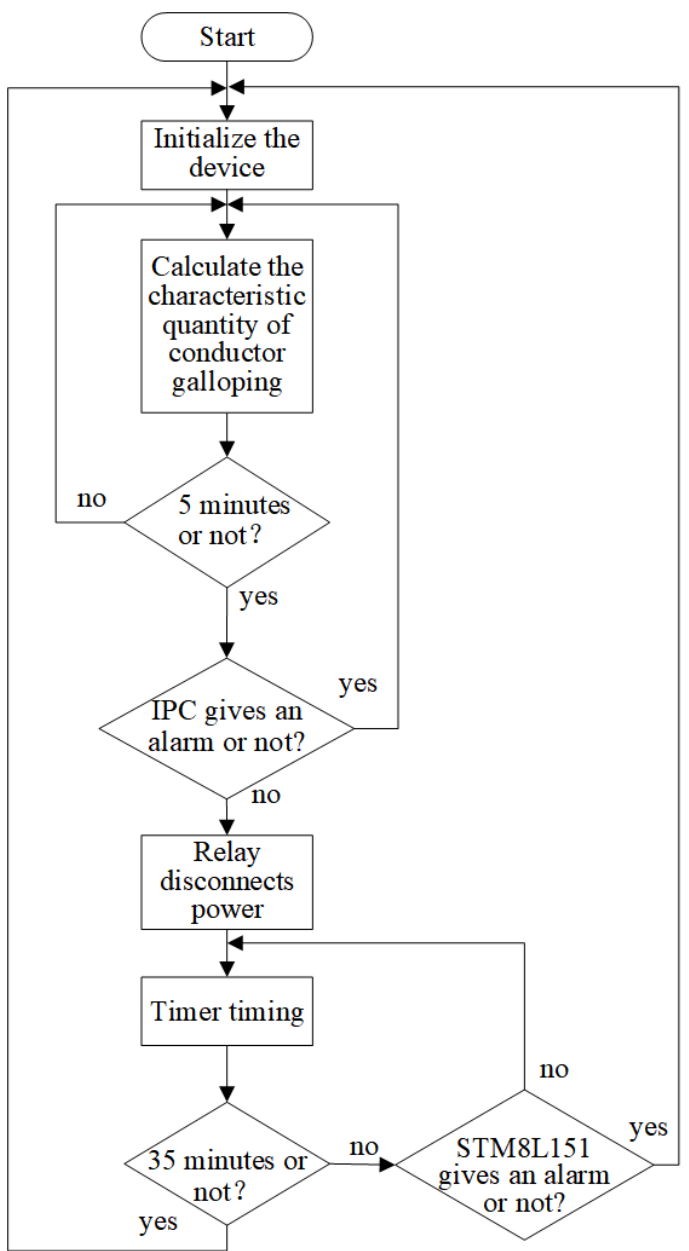
Figure 5. The calculation unit.